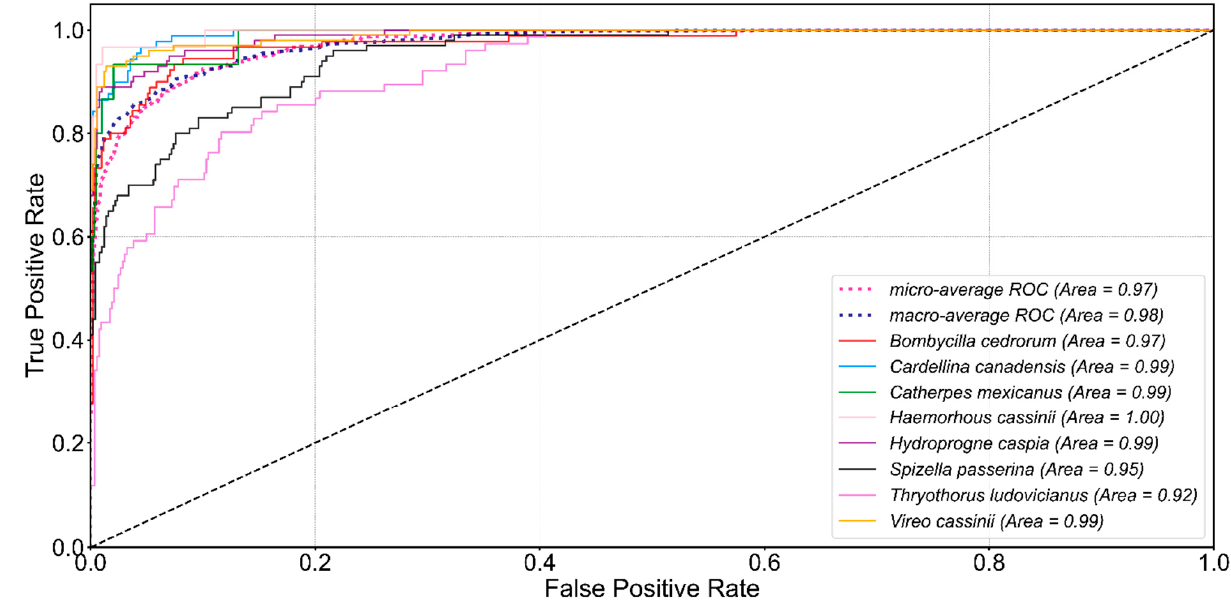
Figure 13. PCA on features of multiple types. ( a ) PCA on raw features ( b ) PCA on learned features.